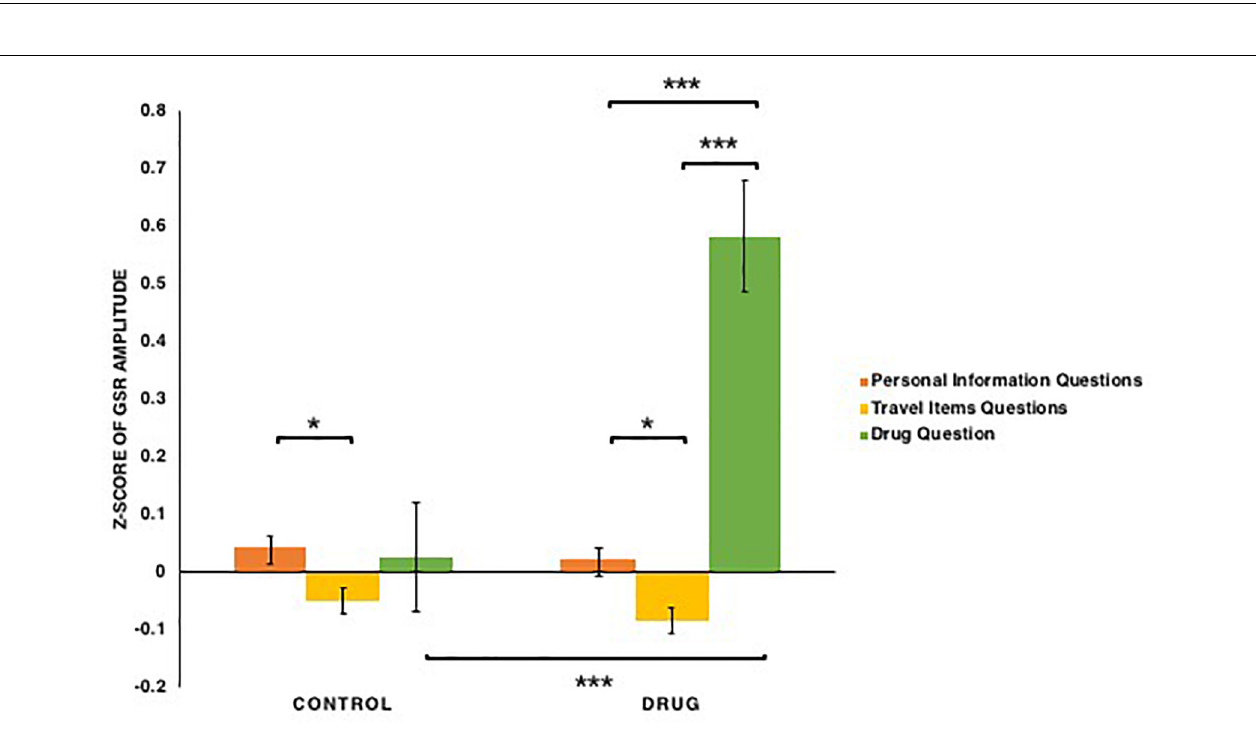
FIGURE 7 | The z -scores of the peak-to-peak amplitude of GSR among participants in the control and drug conditions when answering three types of questions: basic personal information, carrying common travel items, carrying drugs. Note that ∗ p < 0.05, ∗∗ p < 0.01, ∗∗∗ p < 0.001. The error bars SEs.